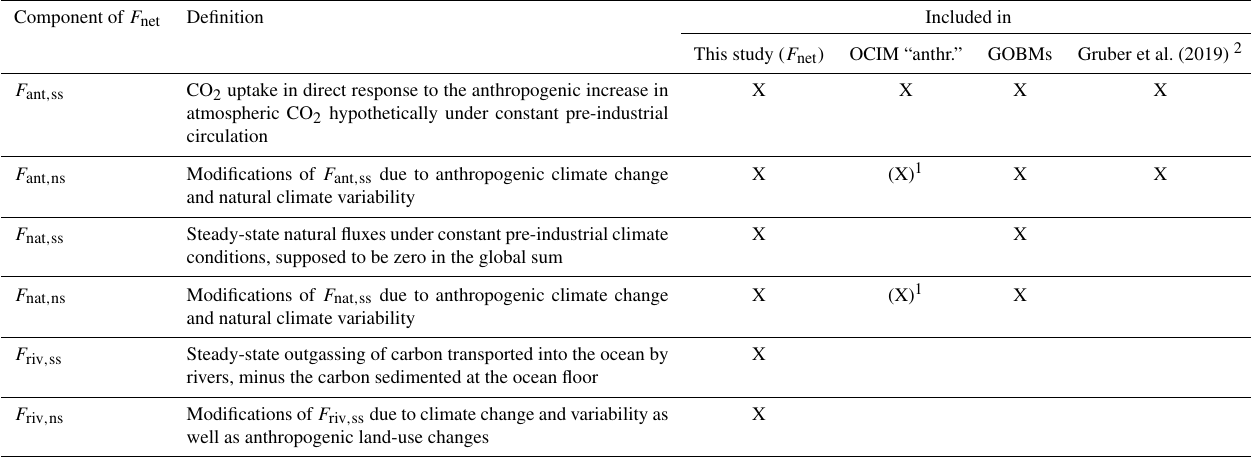
Table A1. The components of the contemporary net sea–air CO 2 flux ( F net = F ant , ss + F ant , ns + F nat , ss + F nat , ns + F riv , ss + F riv , ns ) according to Hauck et al. (2020) and whether or not they are included in the individual estimates shown in Figs. 8, A1, and A2. Component of F